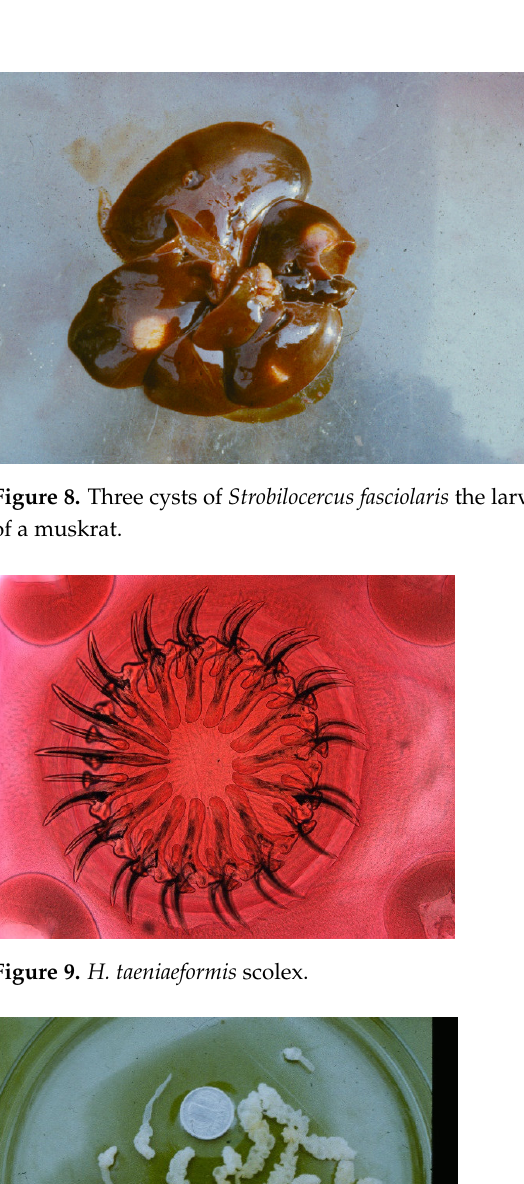
Figure 7. Opisthorchis felineus. Deeply lobed testes are situated at the posterior end. The uterus be-